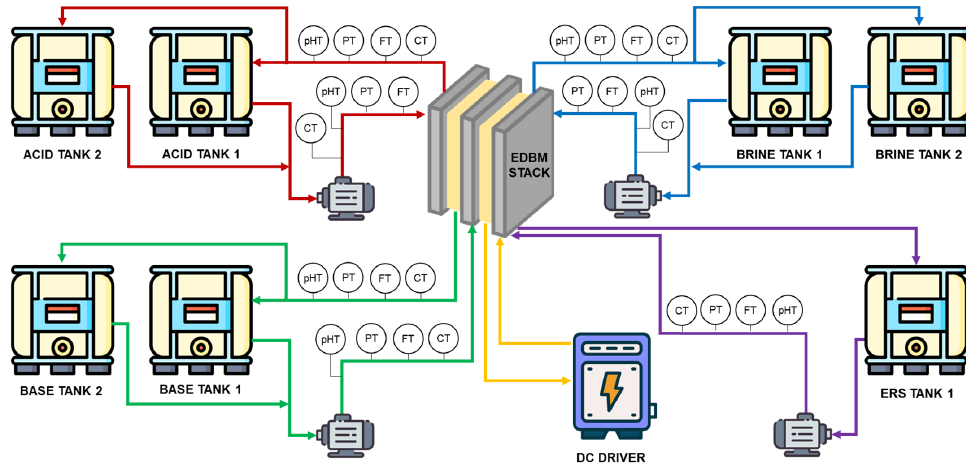
Figure 2. Simplified flowsheet of the EDBM pilot plant (adapted from [29]). Table 1. Main properties of the FuMa-Tech BWT GmbH membranes used